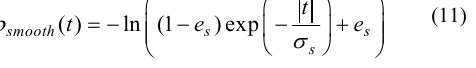
The function  has the form of a potential function of smooth Total Variance (TV), which has the discontinuity preserving property needed for a proper smoothness term (Sun et al., 2003). The parameter e s controls the upper bound (truncation) of the model and the parameter  s defines the sharpness (Figure 5).